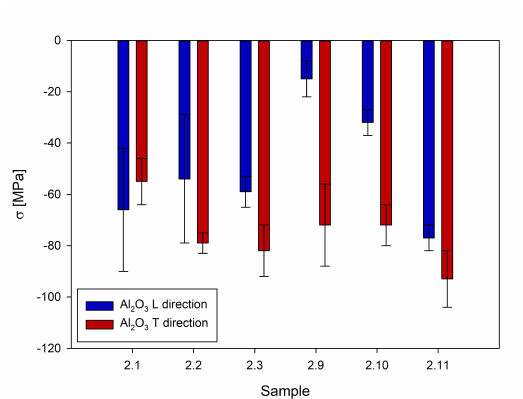
Figure 1. Values of macroscopic residual stresses after grinding by diamond disc (samples x.1-x.3) and AAT (samples x.9-x.11) of Al